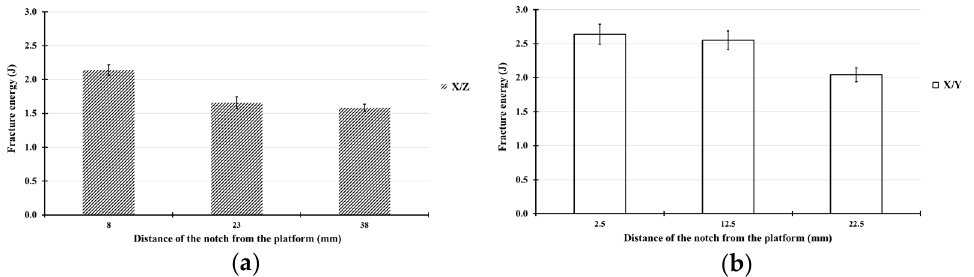
Figure 7. Average fracture energies as a function of notch height for ( a ) X/Z and ( b ) X/Y specimen types without taking into account the manufacturing areas.